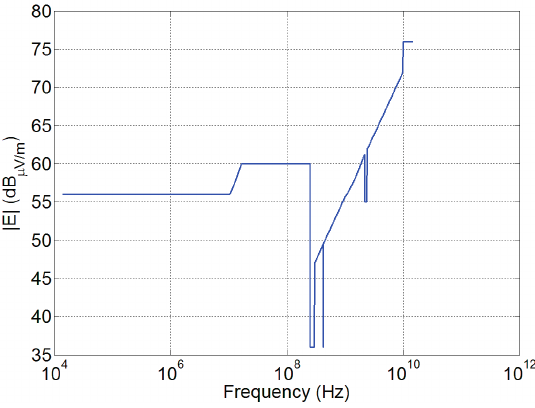
Figure 6. Electric field limits as a worst-case combination of Columbus and Harmony EMC